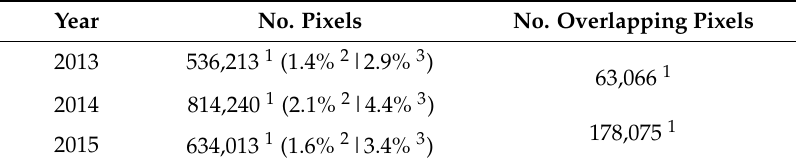
Table 2. Total number of bare soil pixels and the amount of overlapping pixels for the years 2013, 2014, and